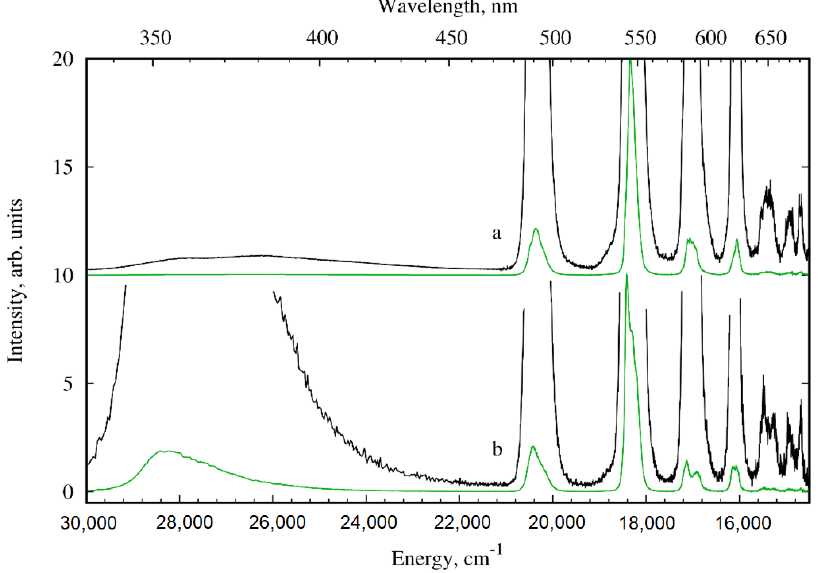
Figure 7. Luminescence spectra of 2 Tb ( a ) and 3 Tb ( b ) at λ ex = 280 nm and T = 300 K in solid state. The black curves show the spectra after magnification.